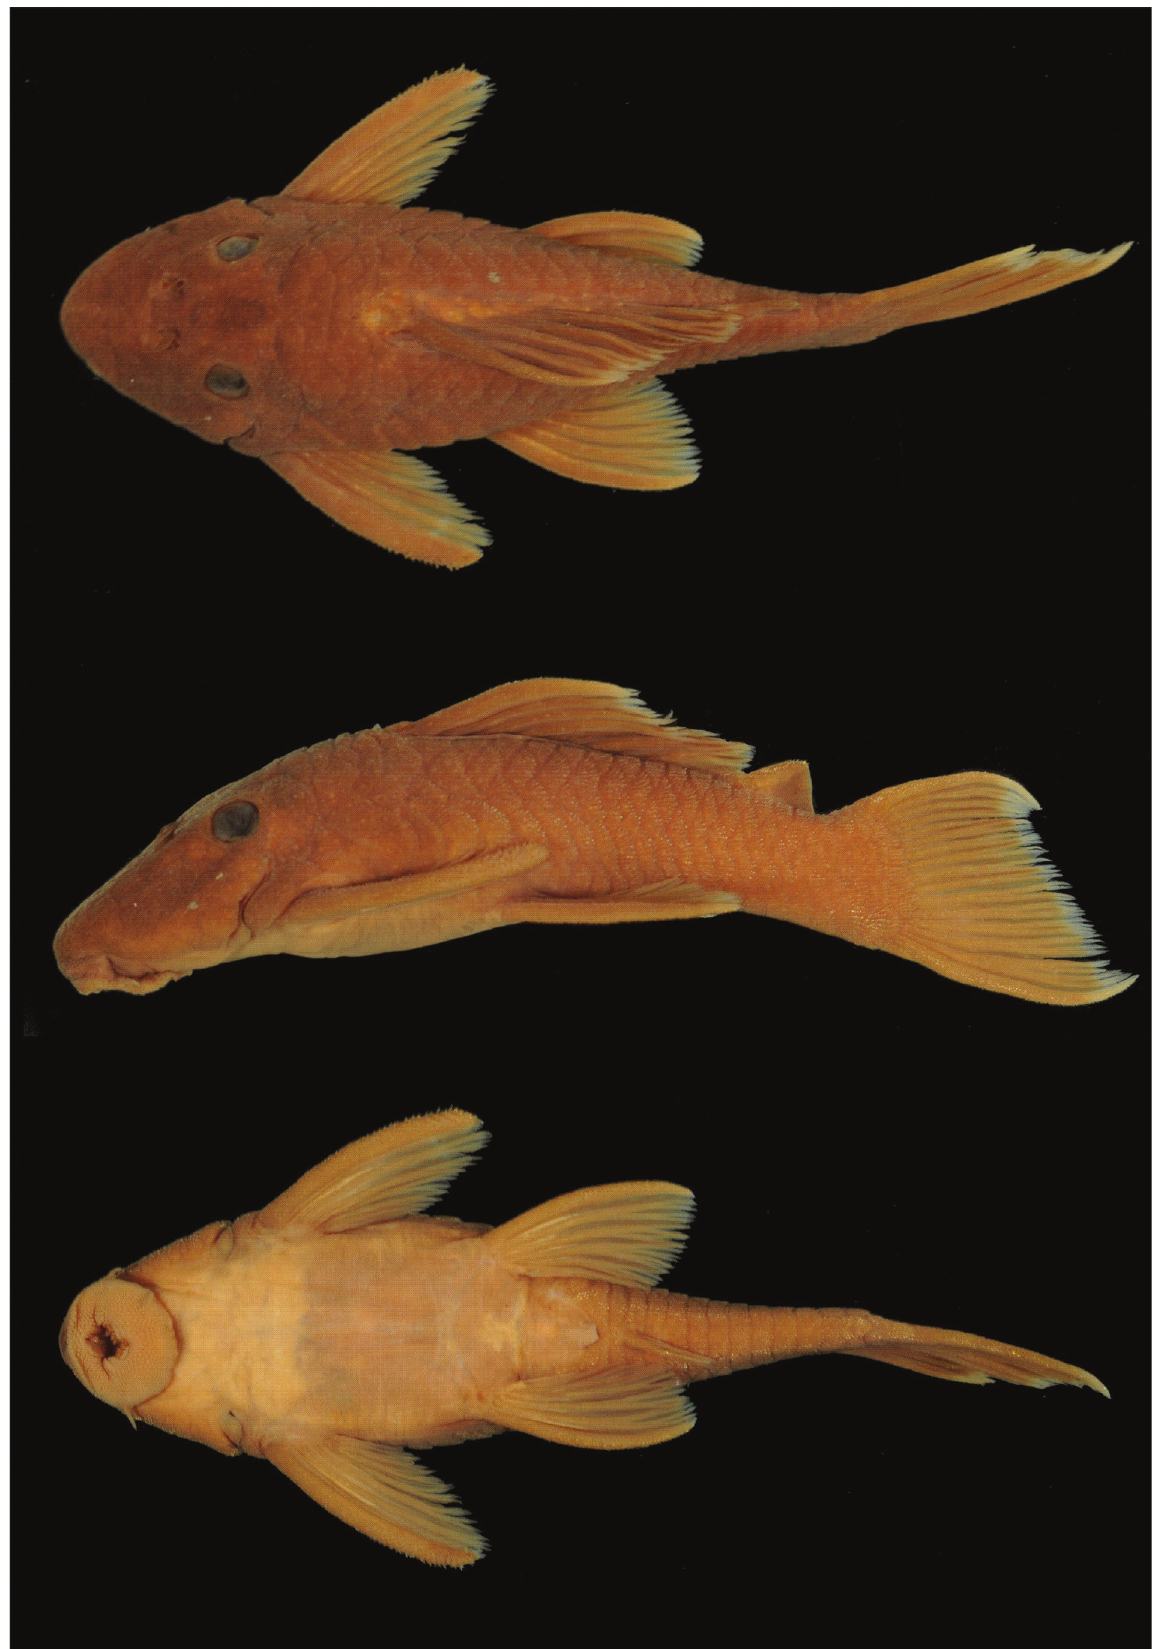
Fig. 1. Spectracanthicus murinus , holotype, MZUSP 22011, 59.7 mm SL, rio Tapajós, Pará State,